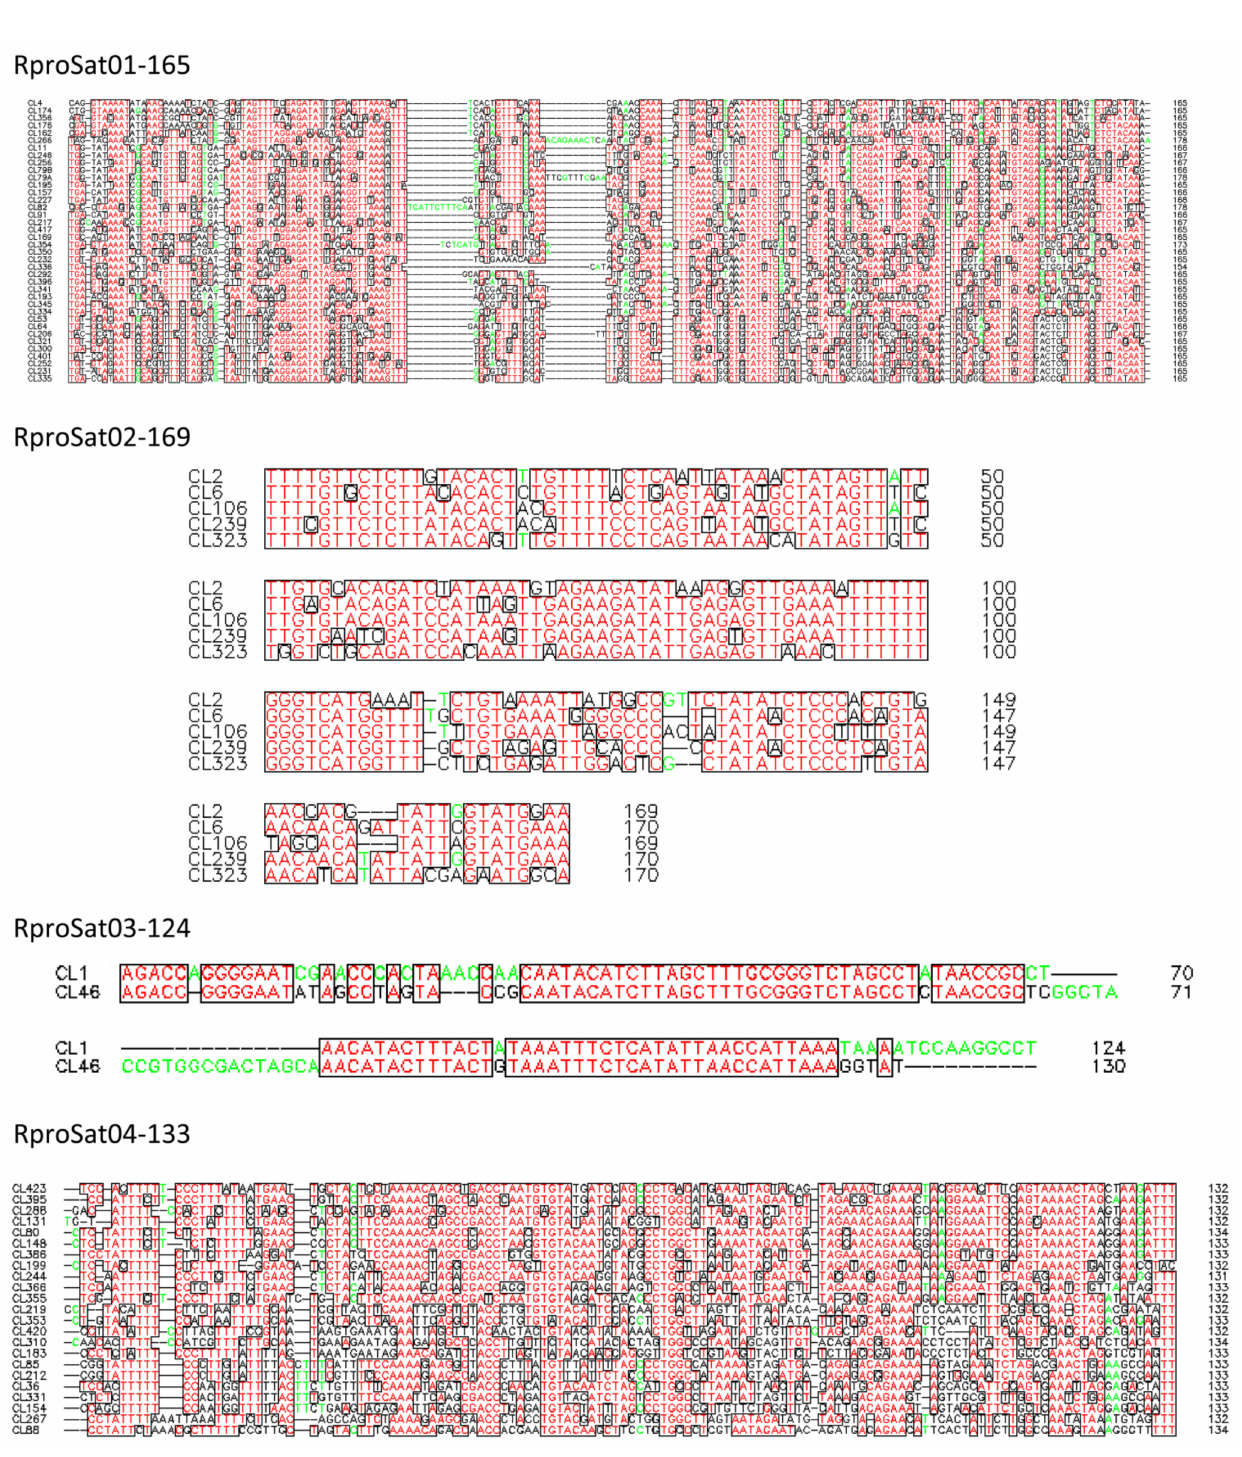
Figure 3. Consensus sequences alignments of the different subfamilies found for the most abundant satDNA families in Rhodnius prolixus . Boxed red letters correspond with conserved position among sequences. Less conserved positions are indicated with green and black